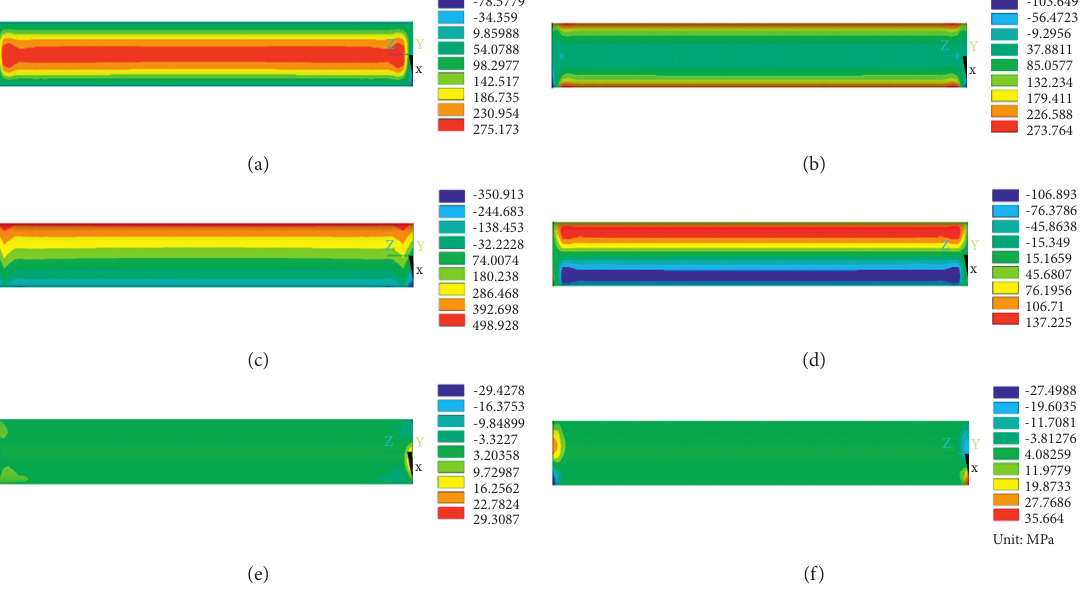
x ; (b) pipe stress σ y ; (c) pipe stress σ z ; (d) pipe stress